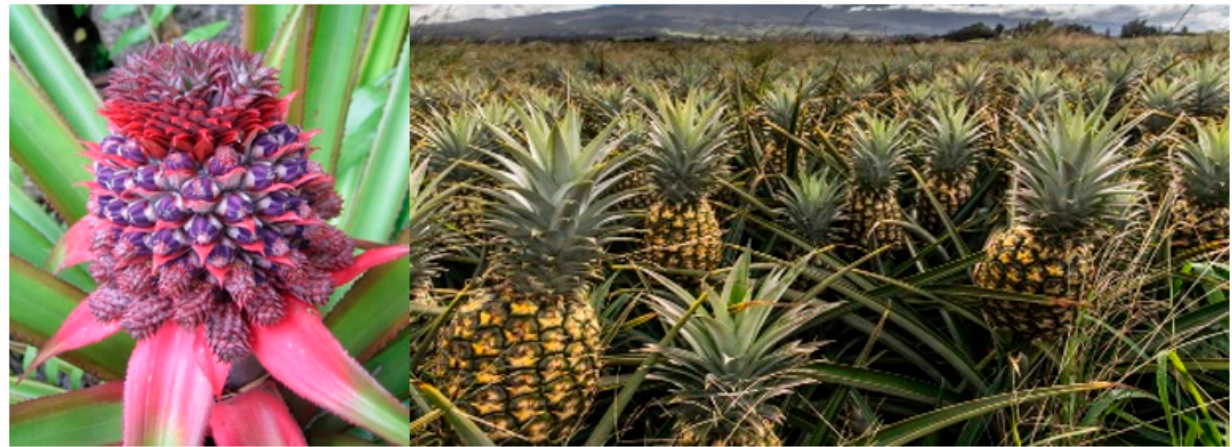
Figure 4. The difference in wild Ananas bracteatus ( left ) and domesticated pineapples A. comosus ( right